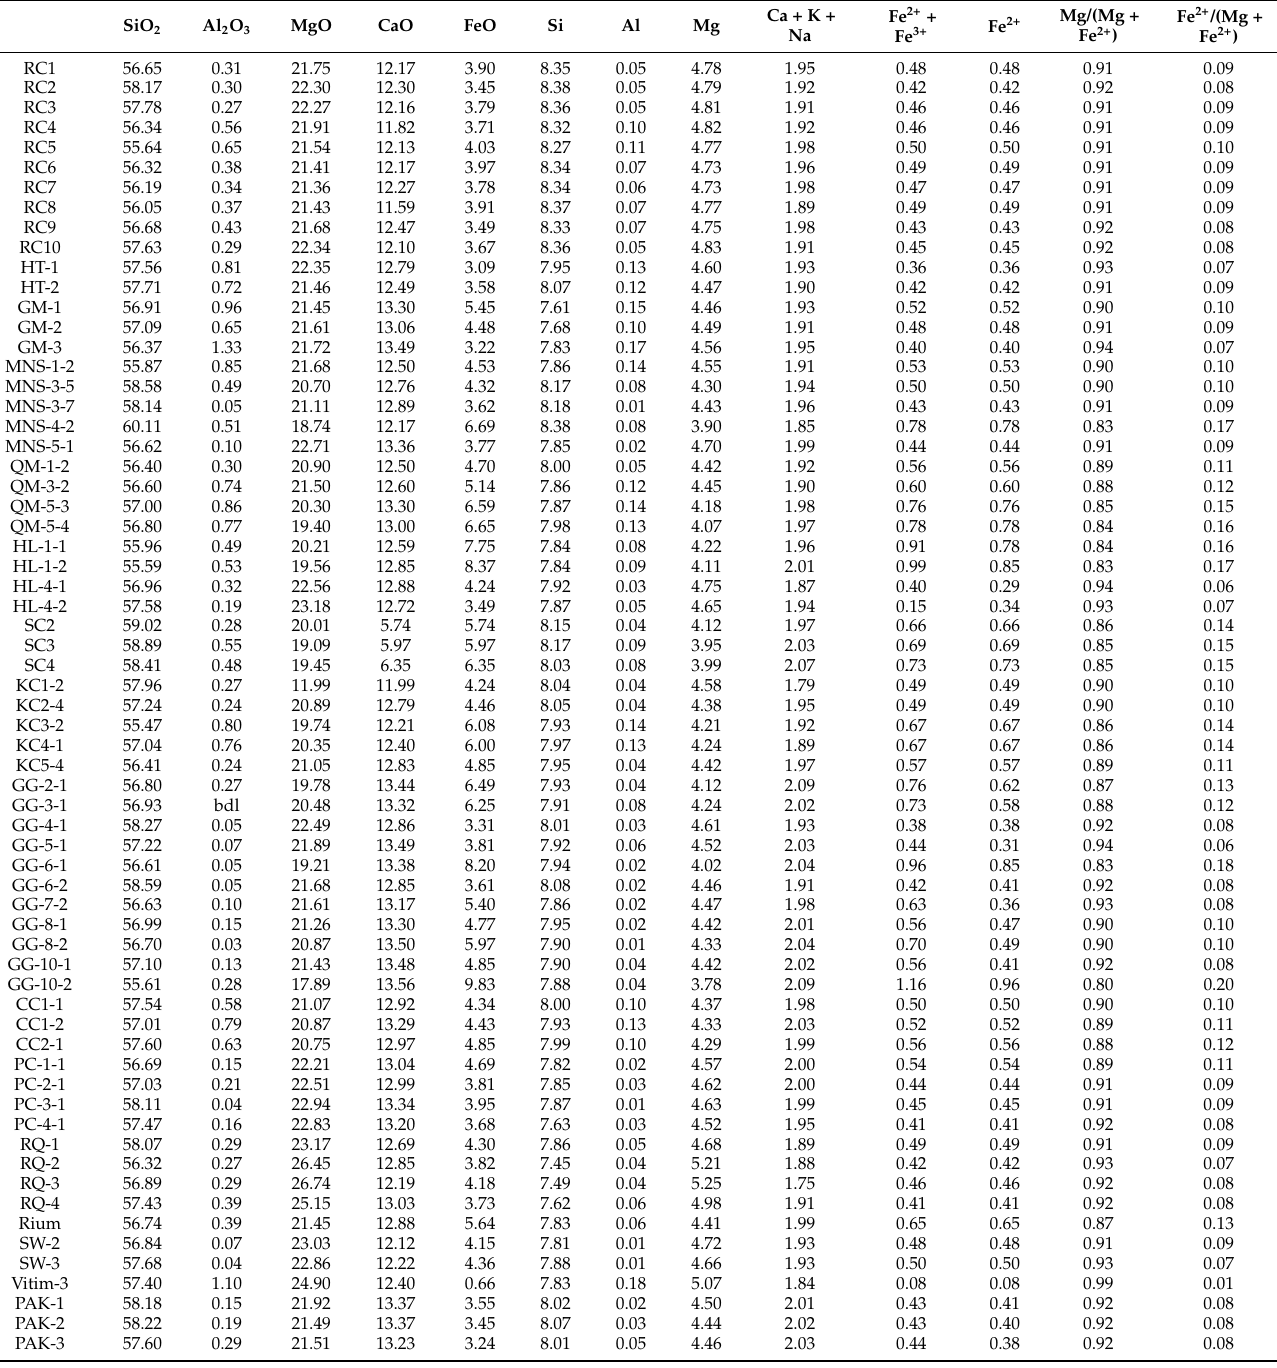
Table A1. Some major elements of samples of green nephrite from different deposits